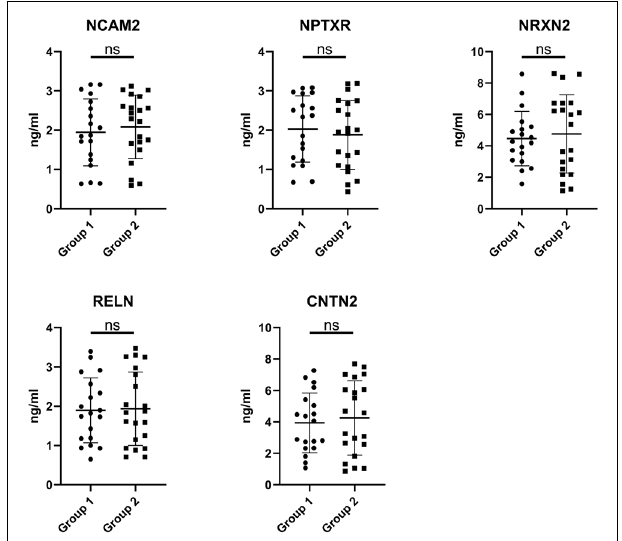
FIGURE 4 | Blood levels of the candidate proteins in the impaired cognition group ( n = 19) compared to the intact cognition group ( n = 21). Group 1: impaired cognition; Group 2: intact cognition; ns, not significantly analyzed by Student’s t